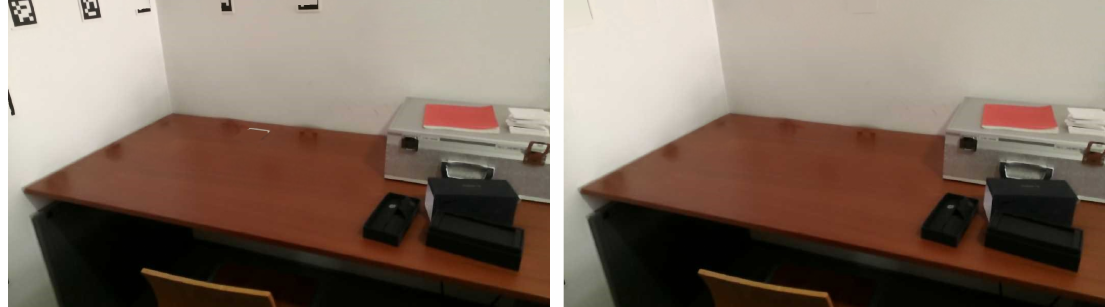
Figure 14. Restoration with cross-inpainting result: ( left ) before optimization; ( right ) after optimization.